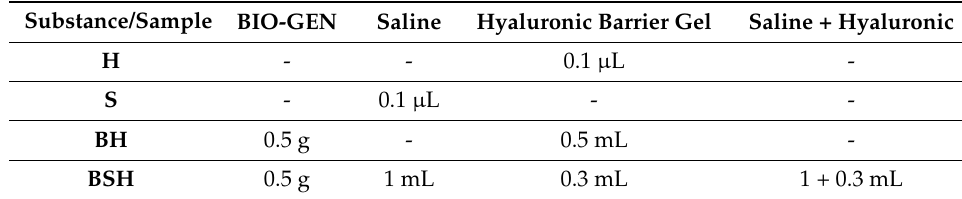
Table 2. Composition and proportion of materials and substances applied on chick embryo chorioallantoic membrane